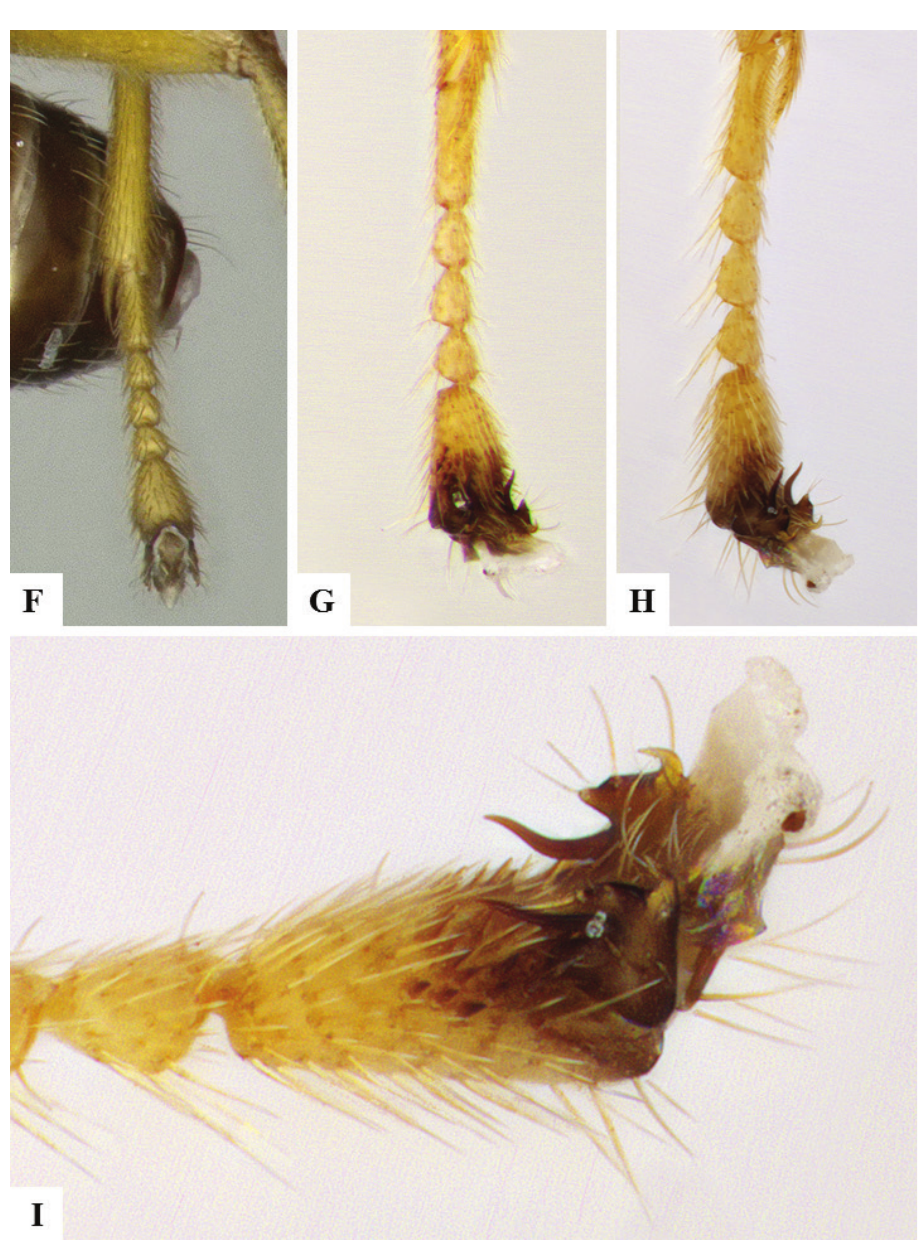
Figure 39. Ungunicus vietnamensis female holotype, details of metatarsus and claws. F Dorsal G Ventral H Ventro-lateral I Last segment of metatarsus and claws,